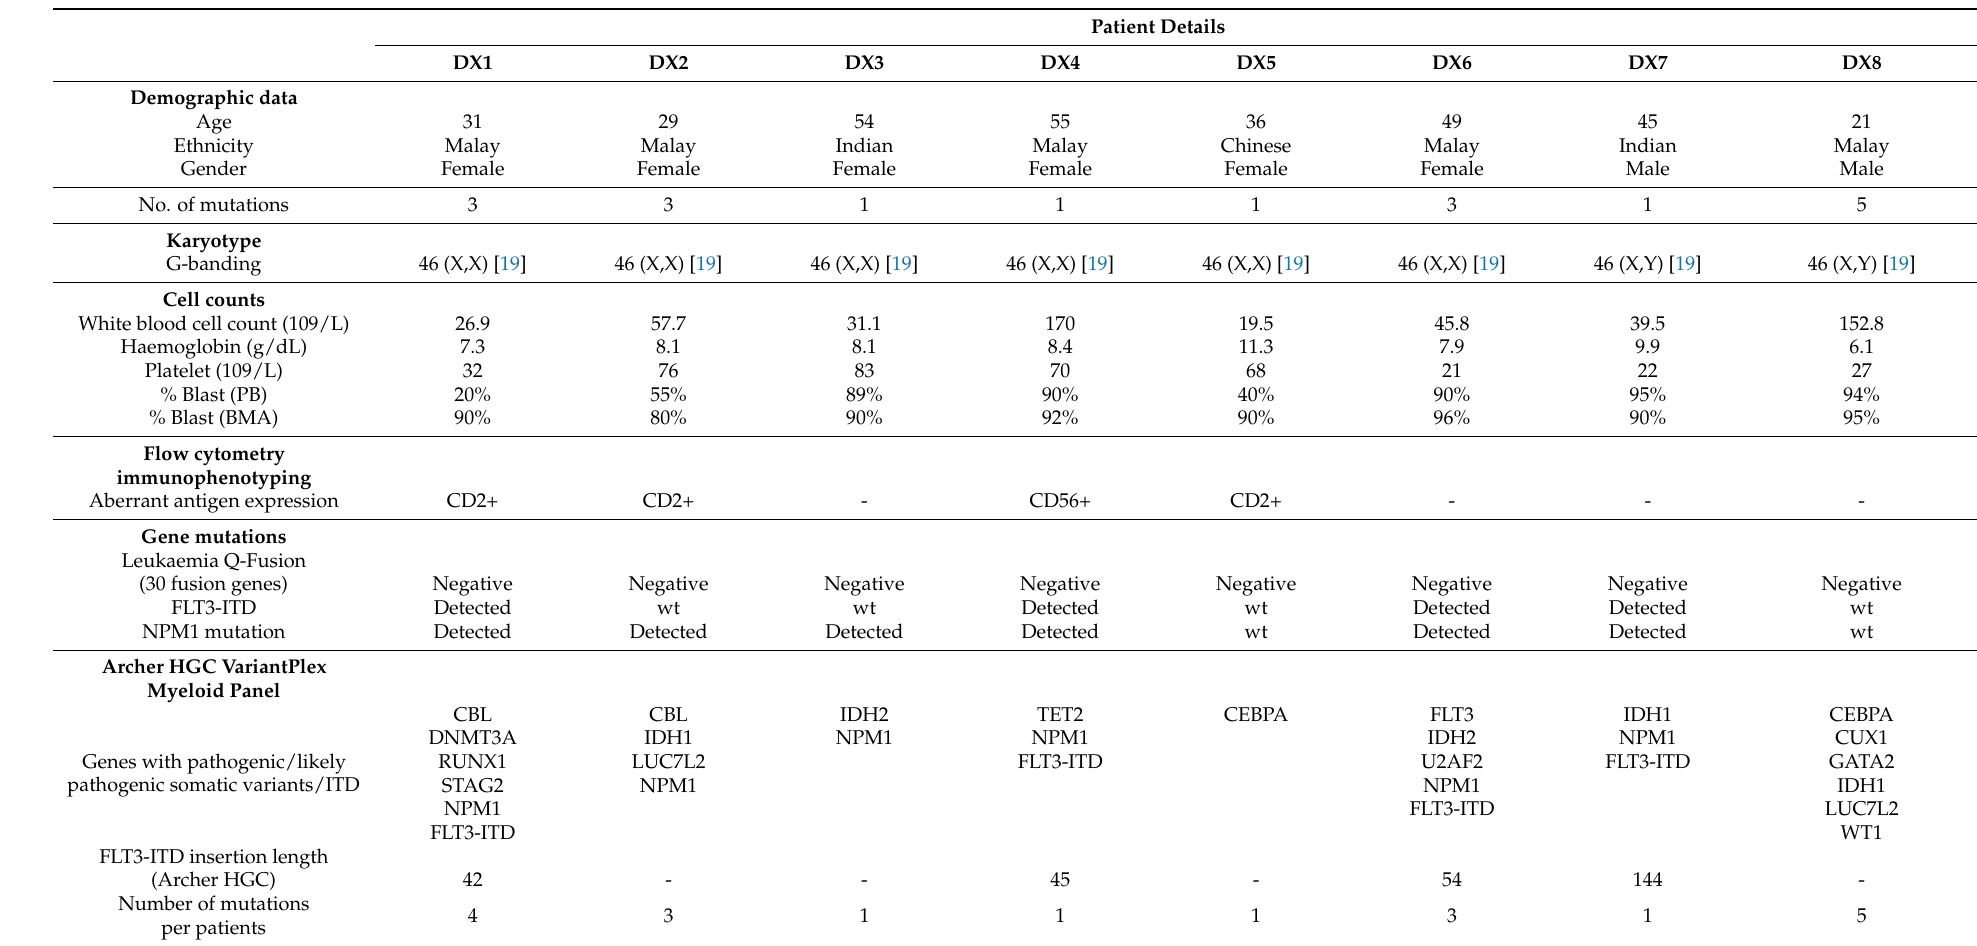
Table 1. Demographic, clinical and laboratory information of patients in this